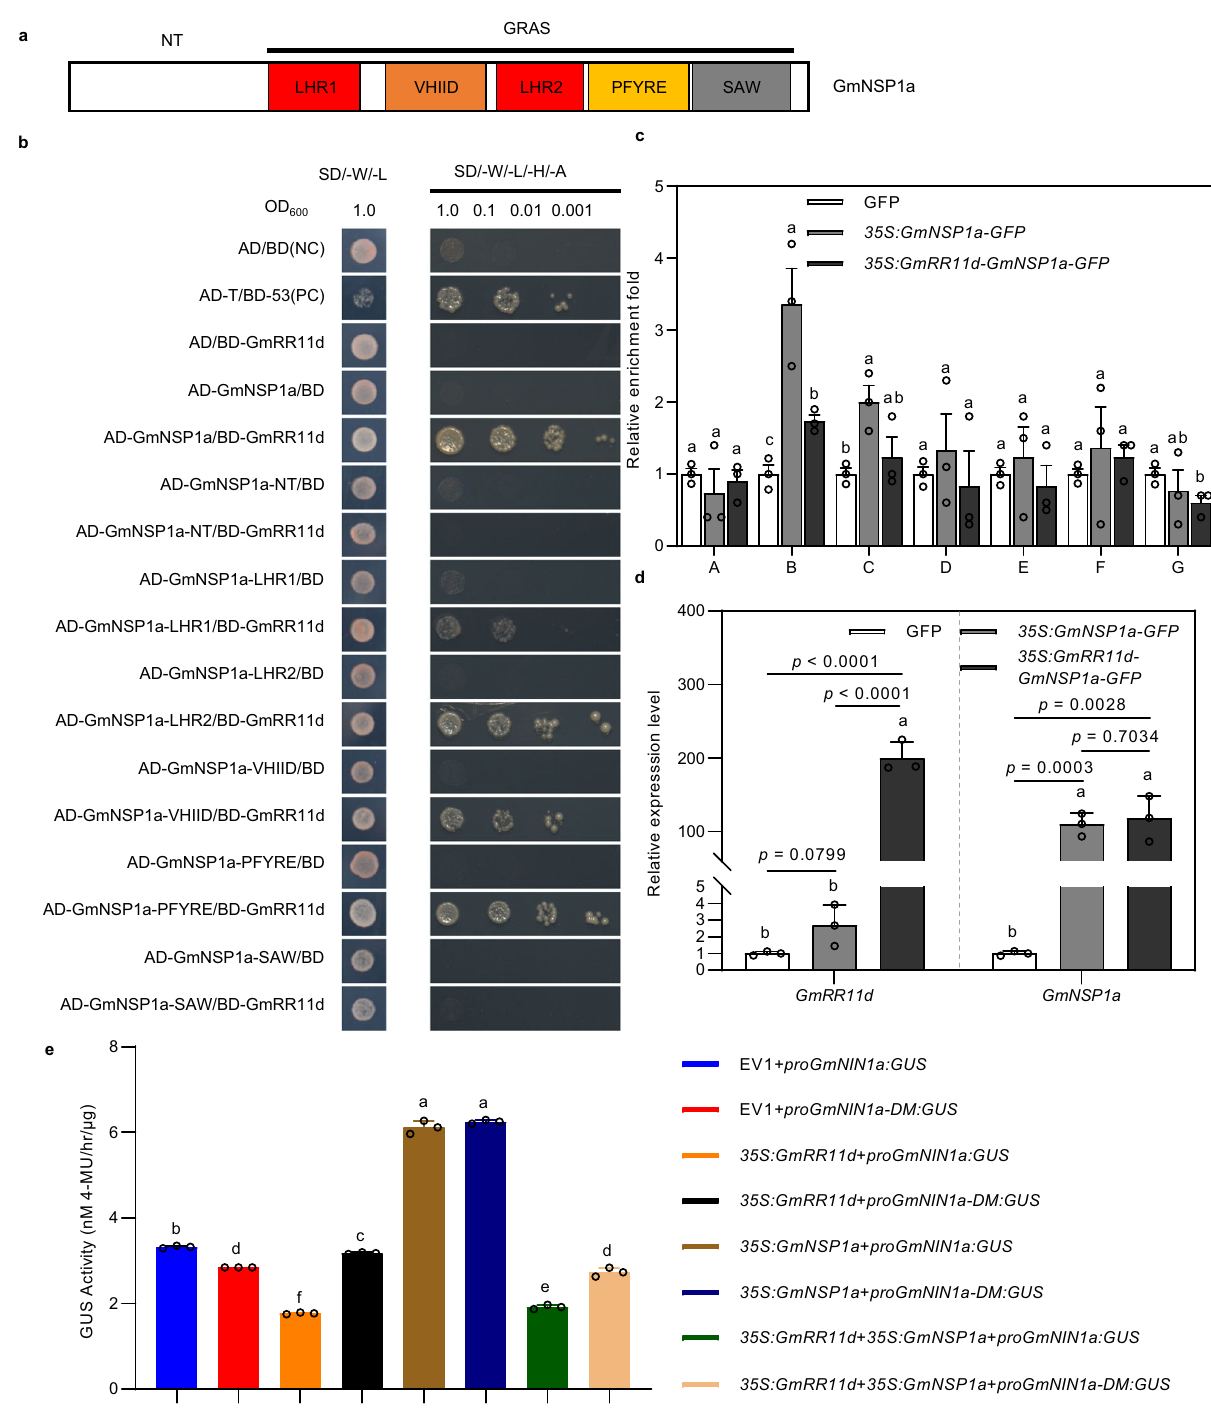
Fig. 6 | GmRR11d interacts with GmNSP1a and inhibits its transcriptional activity. a Domain structure of GmNSP1a. b Domain mapping for the interactions between GmNSP1a or its derivatives and GmRR11d by Y2H assay. Three indepen- dent experiments were performed with similar results. c ChIP assay showing bindingofGmNSP1ato GmNIN1a promoterandtheinhibitioneffectofGmRR11dto the binding of GmNSP1a to GmNIN1a promoter. DNA fragments were co- immunoprecipitatedwithanti-GFPantibodyfromchromatinsuspensionsprepared from 35S : GmNSP1a-GFP , 35S : GmRR11d-GmNSP1a-GFP or control (empty vector) samples.DNAfragmentscorrespondingtotheregionsindicatedinFig.5e.Dataare presented as means±SD of three biological repeats. Different letters indicate